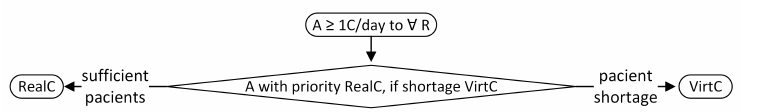
Figure 3. Rules for assigning real or virtual cases (A = assign; C = case; R = resident; RealC = real cases; VirtC = virtual